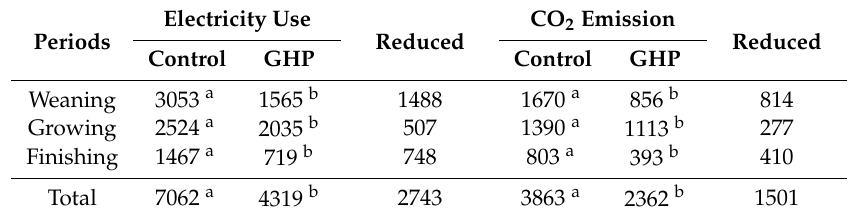
Table 5. E ff ect of the geothermal heat pump (GHP) on electricity consumption (kWh) and CO 2 concentration (kg) in the pig house for 16 weeks.